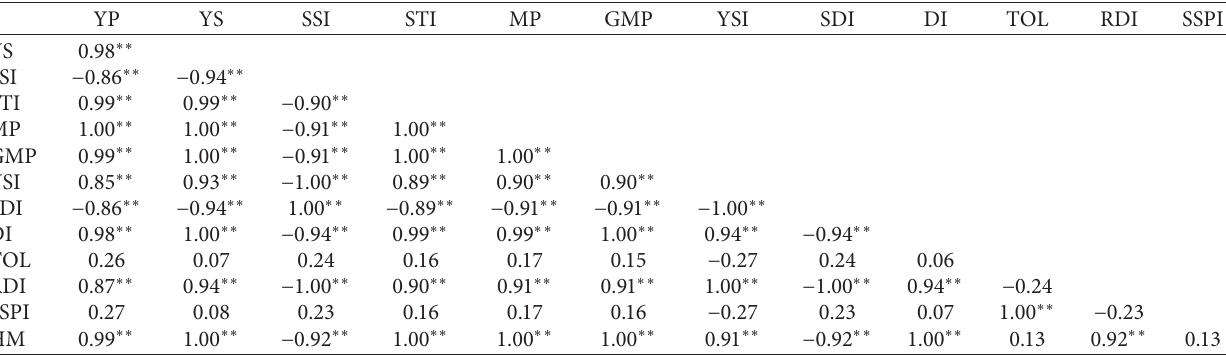
∗ , ∗∗ P < 0 . 05 > ∗ significant at P < 0 . 05, and ∗∗ significant at P < 0.01. Grain yield under normal condition (YP), grain yield under water stress (YS), stress susceptibility index (SSI), stress tolerance index (STI), mean productivity (MP), geometric mean productivity (GMP), yield stability index (YSI), sensitivity drought index (SDI), drought index (DI), tolerance (TOL), relative drought index (RDI), stress susceptibility percentage (SSPI), and harmonic mean